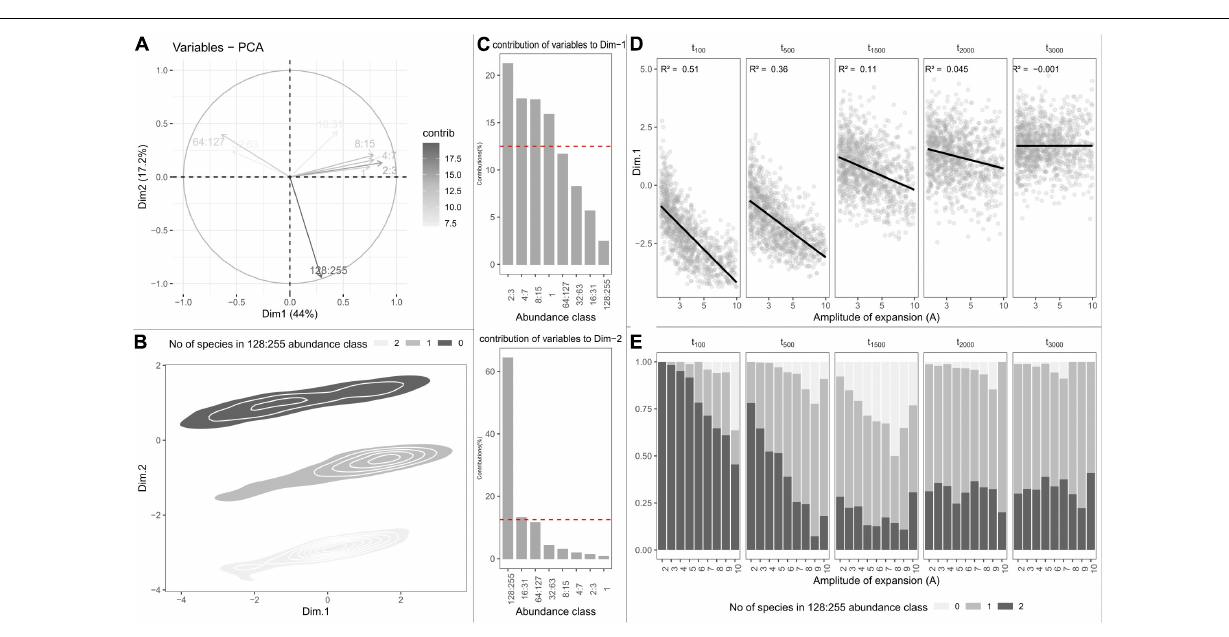
FIGURE 4 | Principal component analysis (PCA) on the simulated species frequency spectra (SFS). (A) Correlation circle showing the contributions of SFS abundance classes to the two first PCA axes. (B) Individual PCA scores projected onto the two first dimensions of the PCA and clustered according to the number of species in the most abundant abundance class. (C) Contributions of SFS abundances classes to the first (top) and second (bottom) axes of the PCA. (D) Variation in PCA-scores along the first dimension depending on the amplitude of expansion (parameter A) and the time (in generations) at which expansion occurred (parameter t c ) . Linear regressions are shown in black with the associated R 2 statistic in the upper-left side of each panel. (E) Variation in the number of points with, respectively, none, one, or two hyperabundant species depending on the amplitude of expansion (parameter A) and the time (in generations) at which expansion occurred (parameter t c